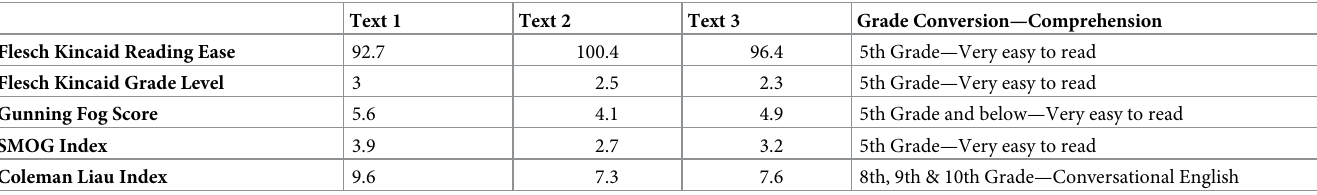
Table 2. Scores of text difficulty, grade conversion and comprehension of the three